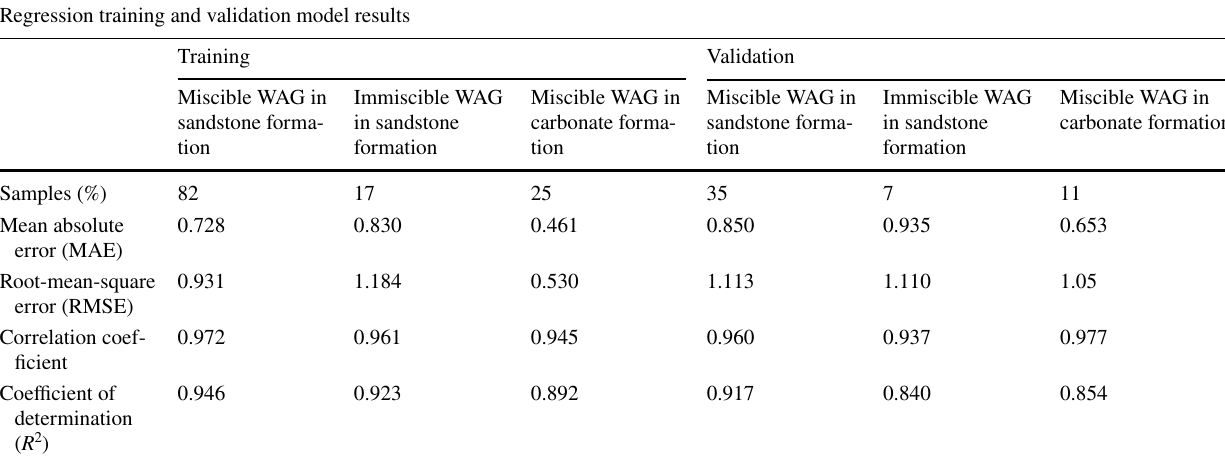
Table 3 Regression WAG incremental recovery factor prediction model output Regression training and validation model